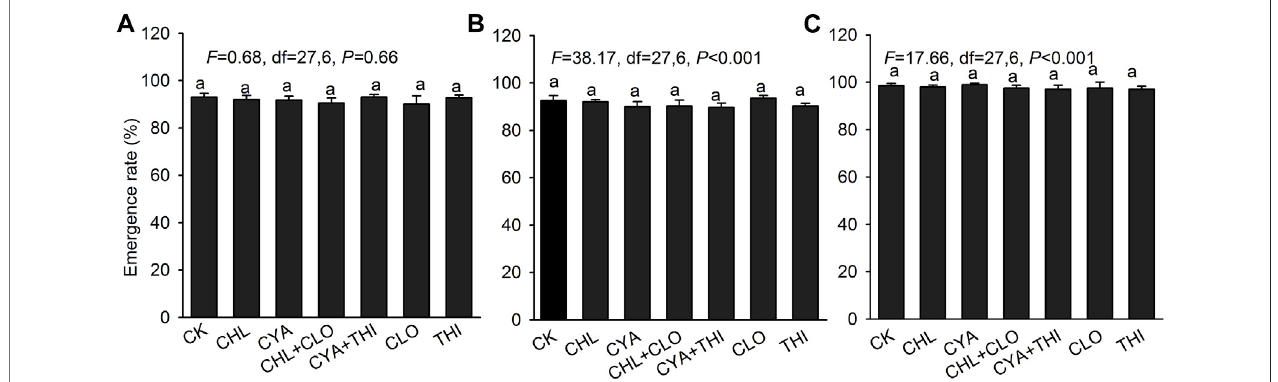
FIGURE 3 | The emergence rate (±SE) of corn seeds after treatment with chlorantraniliprole (CHL), cyantraniliprole (CYA), clothianidin (CLO), thiamethoxam (THI), CHL+CLOandCYA+THI;CKistheuntreatedcontrol.Panels: (A) emergencerateofcornseedsinlaboratoryexperiments; (B) and (C) emergencerateofcornseedsin fi eld experiments in July and September 2021, respectively. Columns labeled with the same letter were not signi fi cantly different using Tukey ’ s HSD test at p < 0.05.